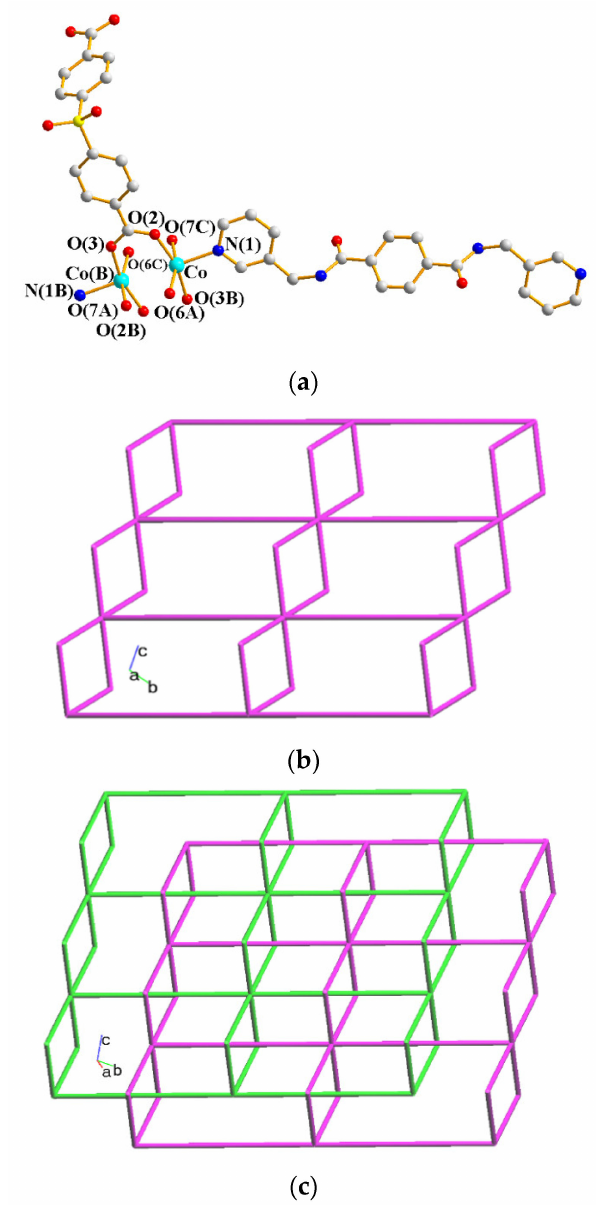
Figure 6. ( a ) The coordination environment of the Co(II) ion in 5 . Symmetry transformations used to generate equivalent atoms: (A) x, y, z − 1; (B) –x + 2, − y + 2, − z + 2; (C) –x + 2, − y + 2, − z + 3. ( b ) A schematic drawing showing the 2D layer with the 2,6L1 topology. ( c ) A schematic drawing showing the 2-fold interpenetrated 2D